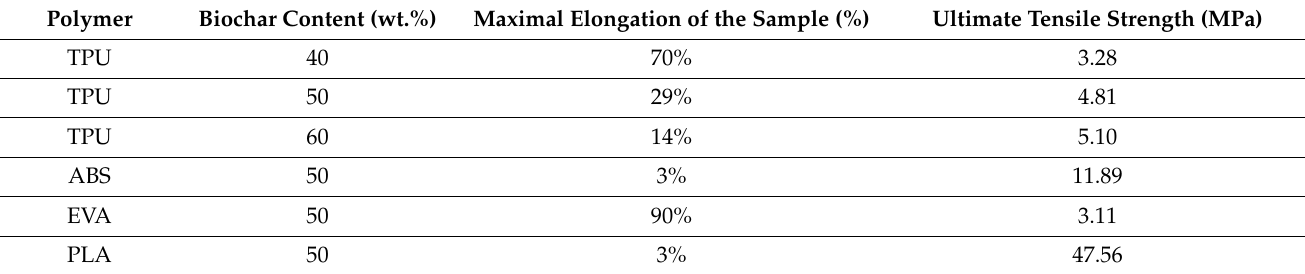
Table 2. Results of mechanical measurements of the composite fibres.